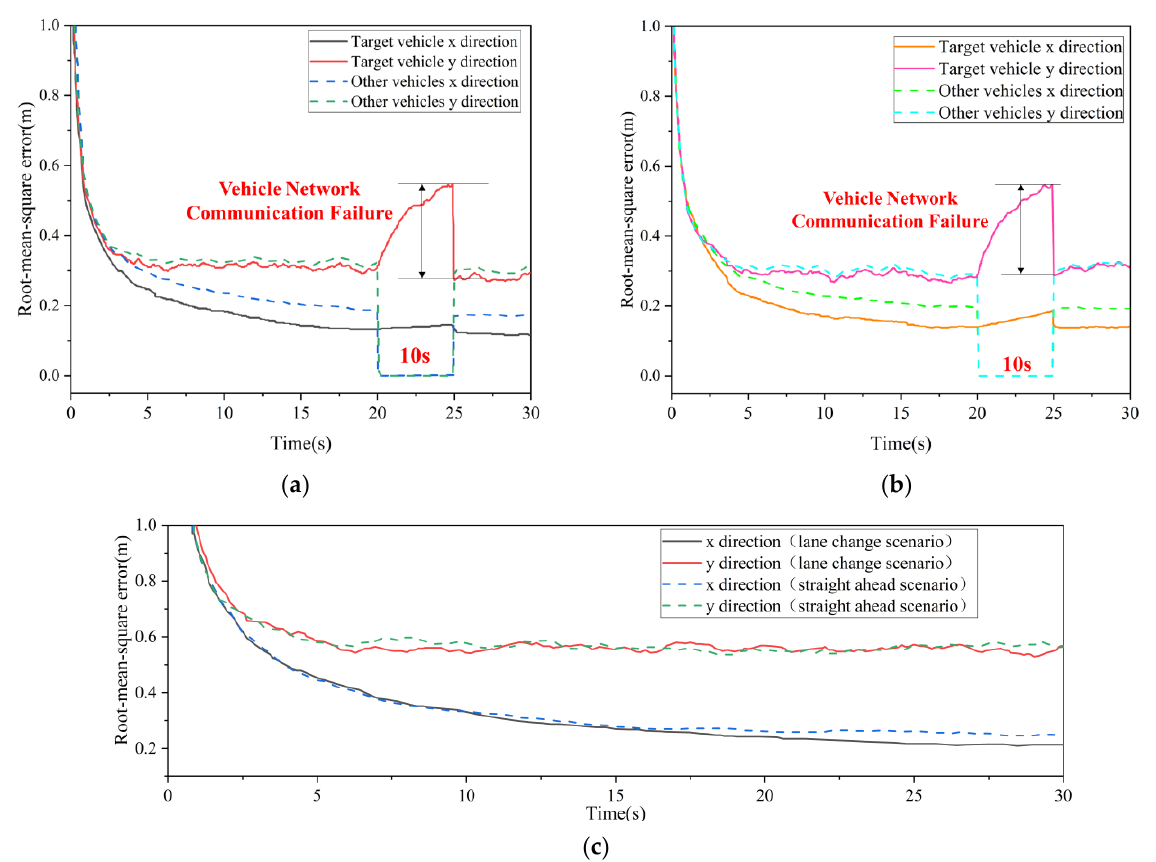
Figure 9. ( a ) Multi-vehicle cooperative positioning errors in lane change scenarios; ( b ) Multi-vehicle cooperative positioning error in straight-ahead scenario; ( c ) Individual vehicle positioning error.